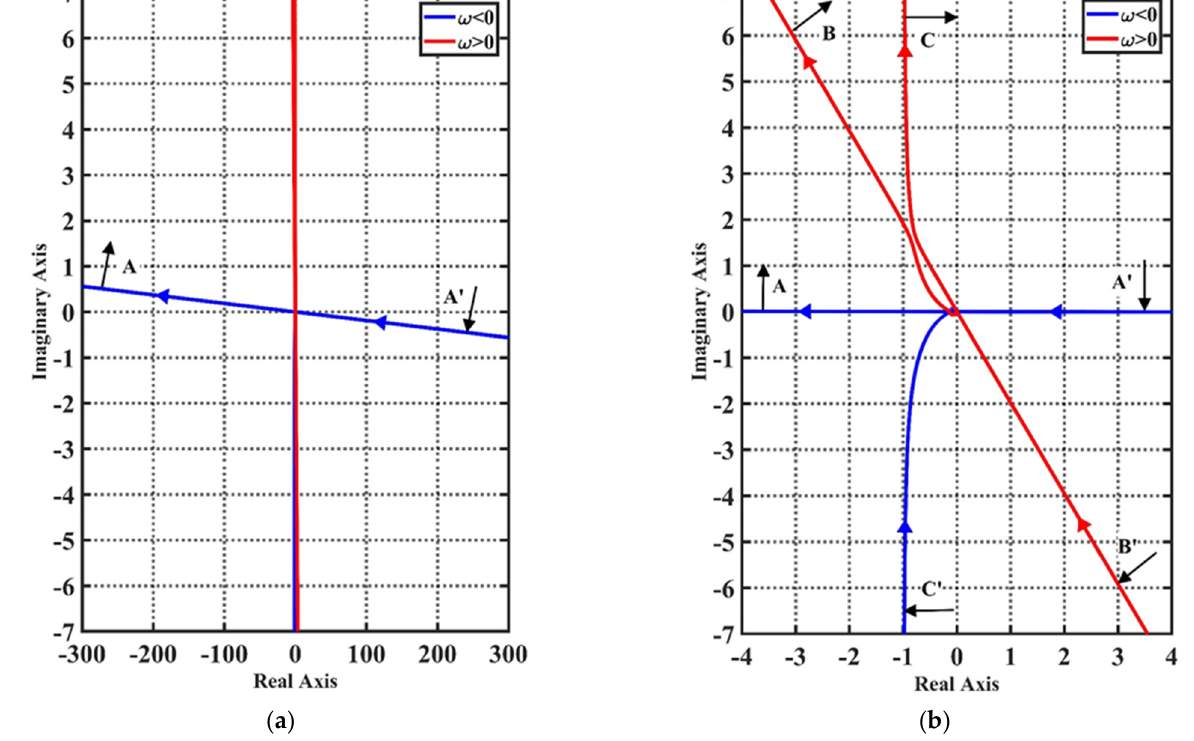
Figure 12. Inverse Nyquist diagram for Ω = 600 rad/s when Z s = − 0.3 mm. ( a ) Global; ( b ) Local. The inverse Nyquist curve turns 180 (cid:2925) clockwise from A to A (cid:4593) , B to B (cid:4593) and C to C (cid:4593) with infinite radii. Thus, it circles (−1,j0) zero times.